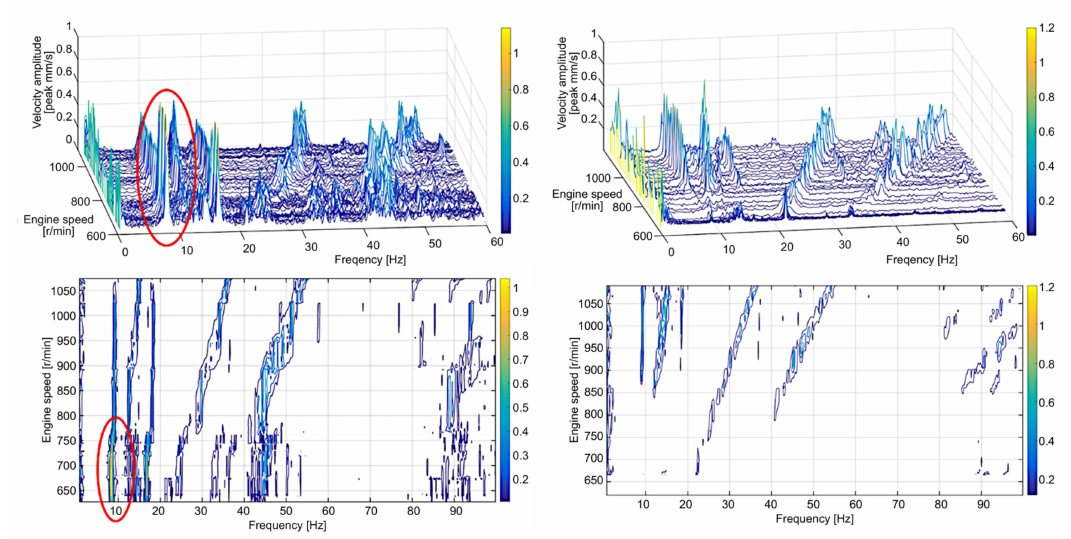
Figure 11. Velocity vibration amplitude measured at bearing housing in transverse direction. With SETV being dominant (left); Without SETV being dominant (right).